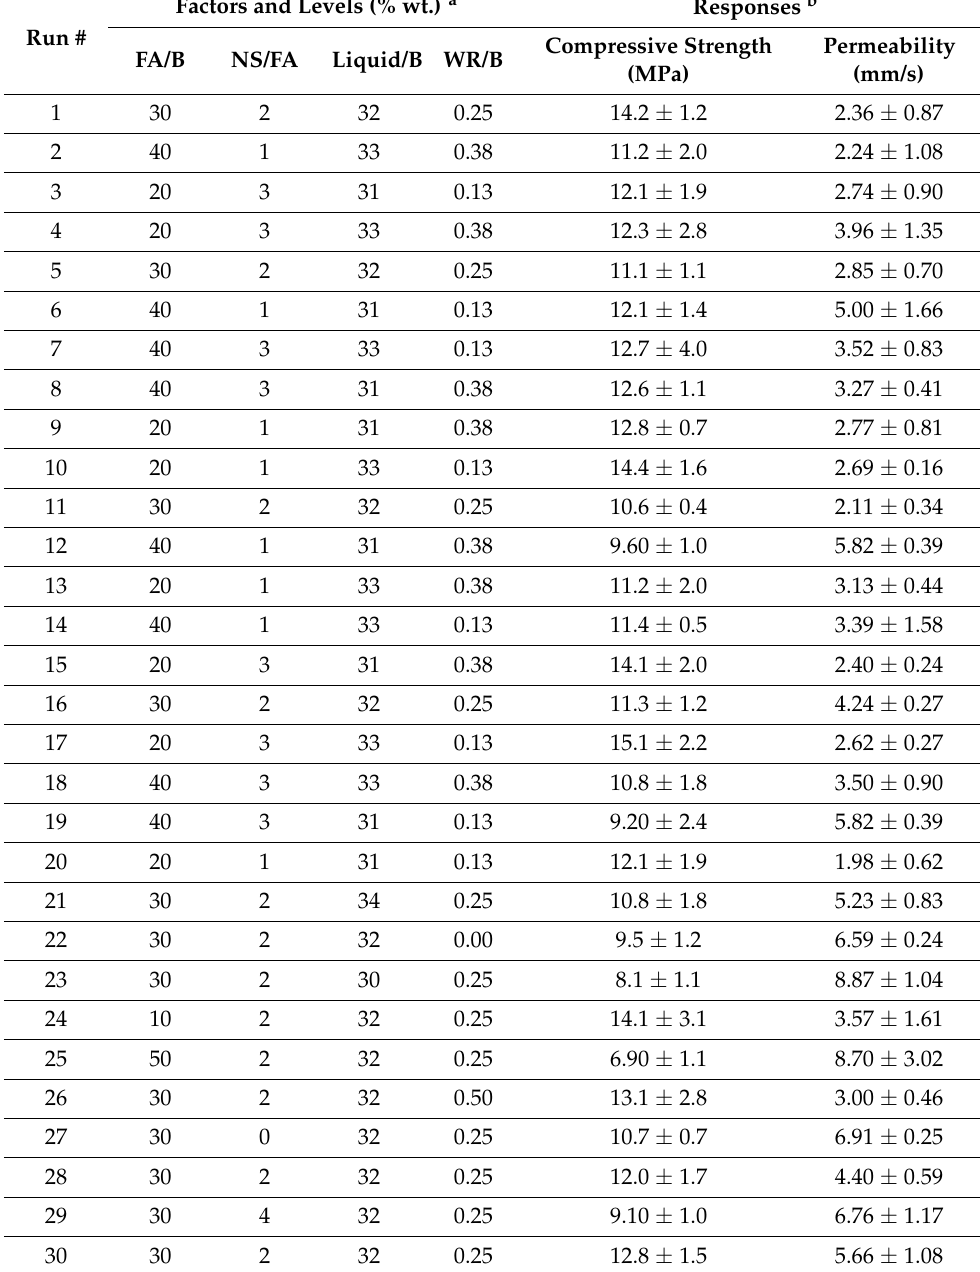
Table 6. Test results of the compressive strength and permeability for SMPC. Factors and Levels (% wt.) Run #